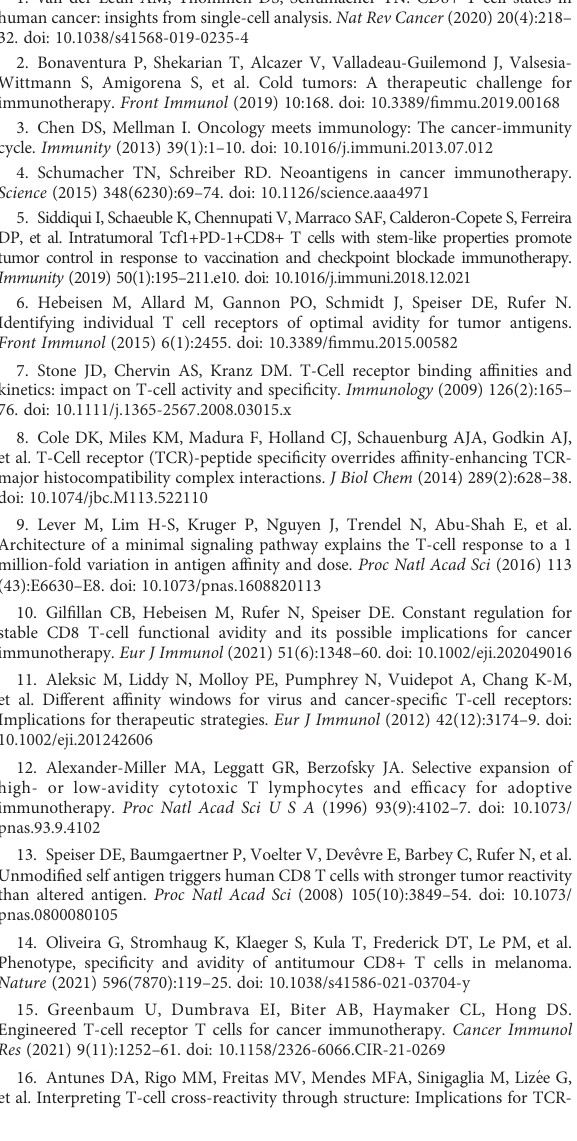
Pearson correlation analysis. (B) Correlation between K i af fi nities ( m M) obtainedfromthecellularbluepeptidecompetitionassayandpercentage rank values obtained from the PRIME2.0 algorithm for both NY-ESO-1 (left) and Melan-A/MART1 (right) variants. Native and analog peptides are shown in blue and red for both peptides, respectively. SUPPLEMENTARY FIGURE 3 Correlation analysis between functional avidity and peptide:HLA af fi nity. (A, B ) Correlation analysis between functional avidity EC 50 values and peptide:HLA K i af fi nity from the individual cancer patient-derived T cell clones isolated after EAA or ELA vaccination. ( C ) Correlation analysis between functional avidity EC 50 values and peptide:HLA K i af fi nity from the individual cancer patient-derived T cell clones isolated from TILNs. Individual R square values and slopes from best fi t linear regression lines are